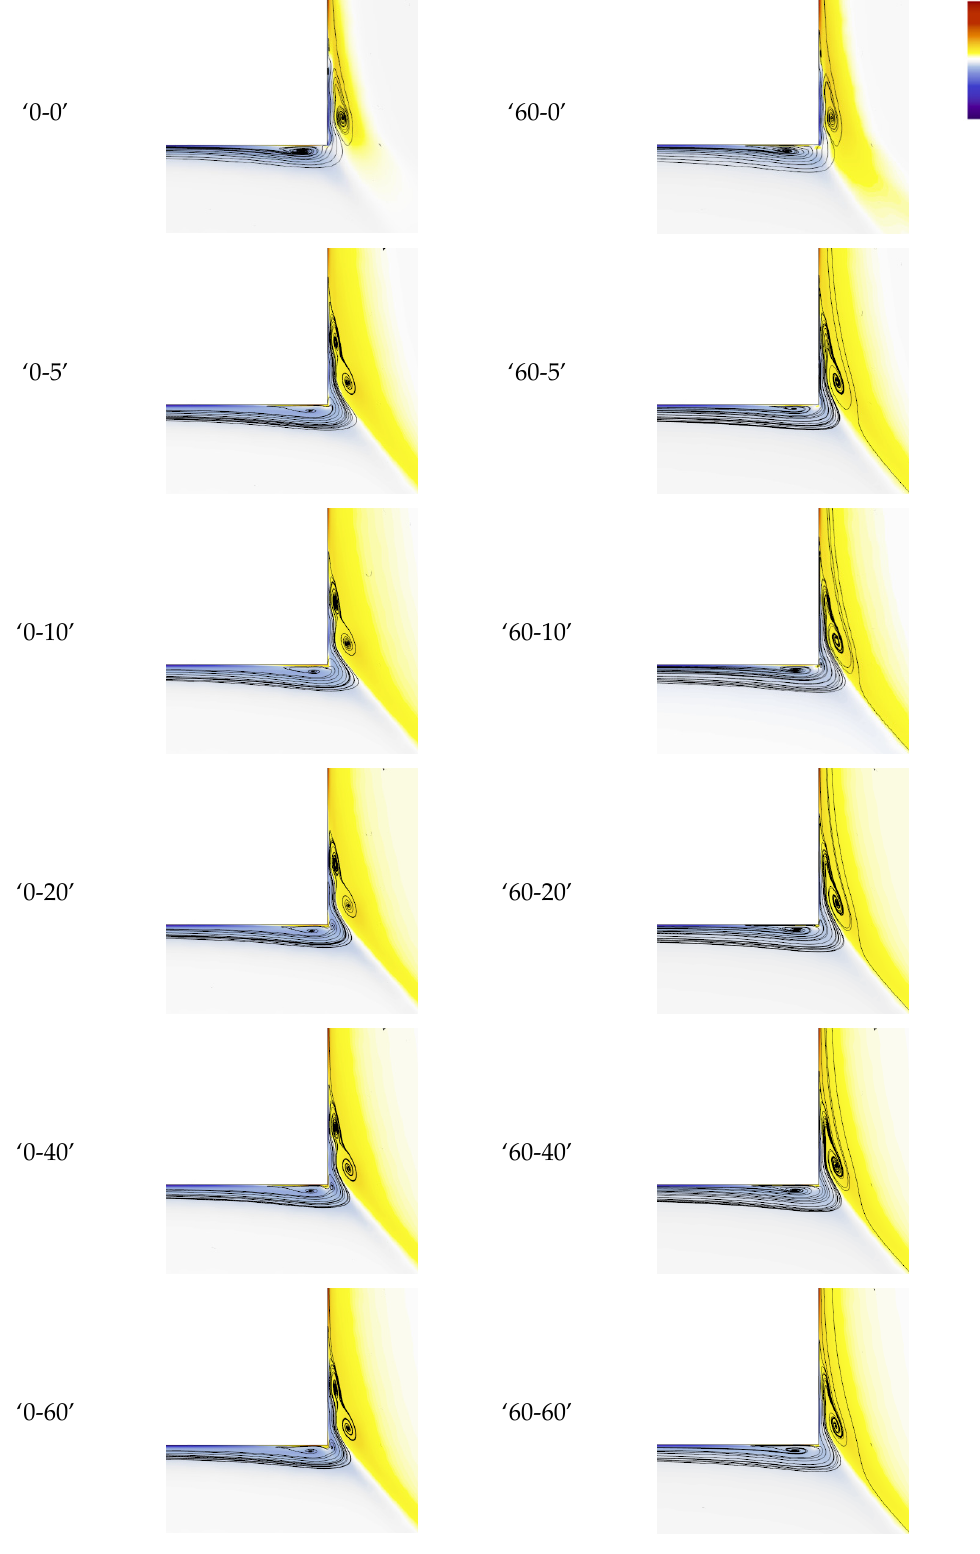
Figure 13. Contour plots of in-plane mean velocity streamlines coloured by ω ∗ y on the XZ symmetry plane for cases with uniformly distributed BCs and with fully developed BCs at the main inlet— Upstream region.